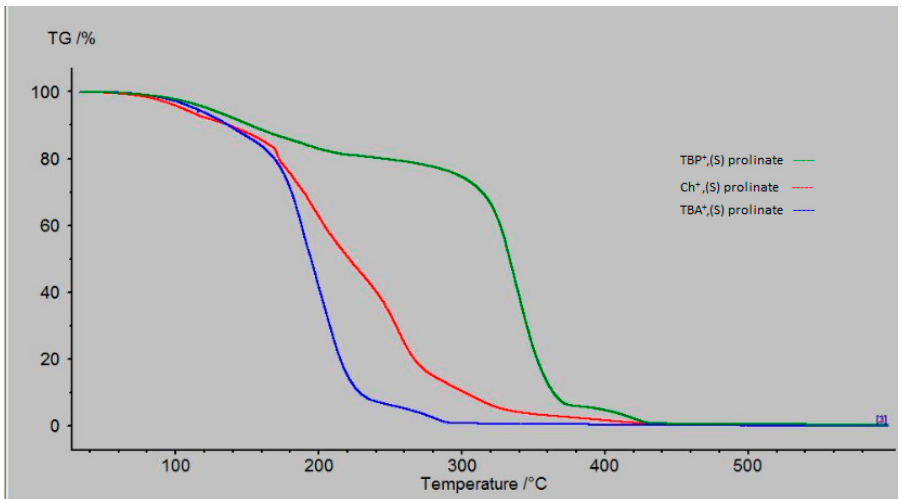
Figure 1. Thermal decomposition of ionic liquids 1–3.